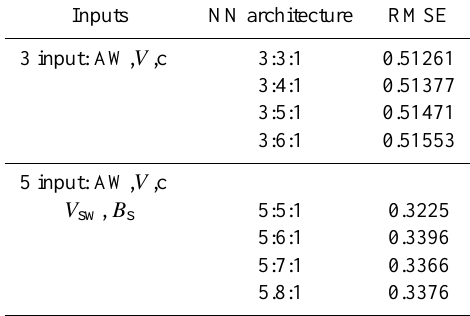
Table 2. Determination of an optimum NN architecture over the validation data set. Optimized NN architectures are highlighted for 3 and 5 inputs,